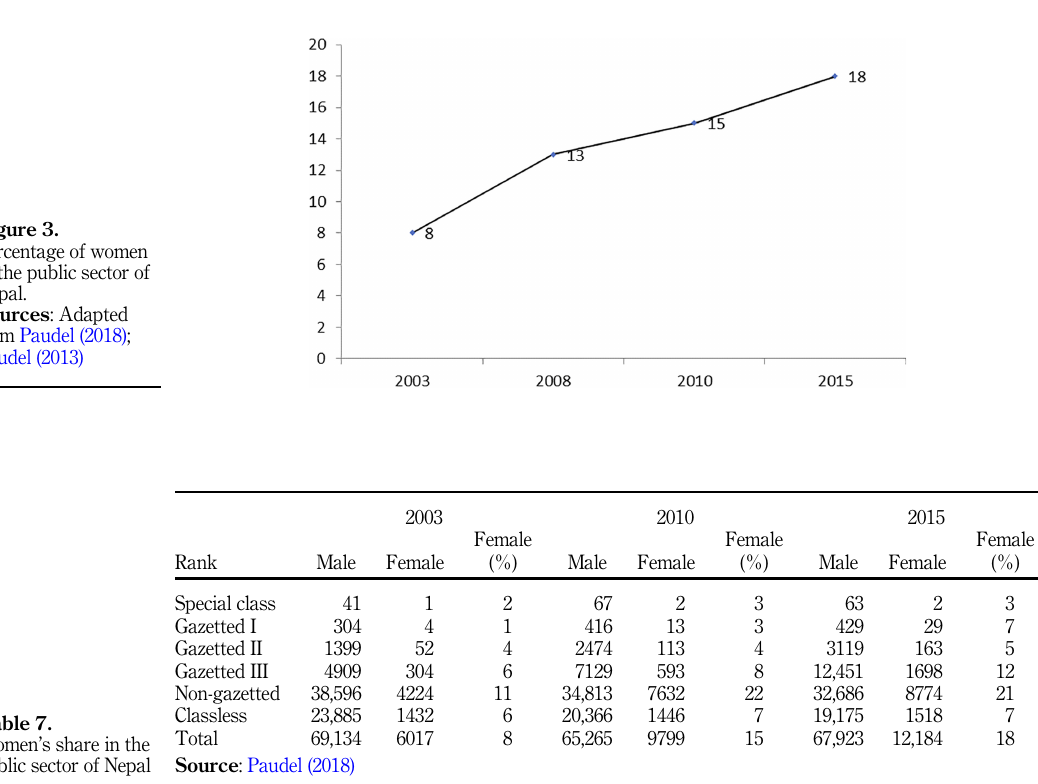
Table 7. Women ’ s share in the public sector of